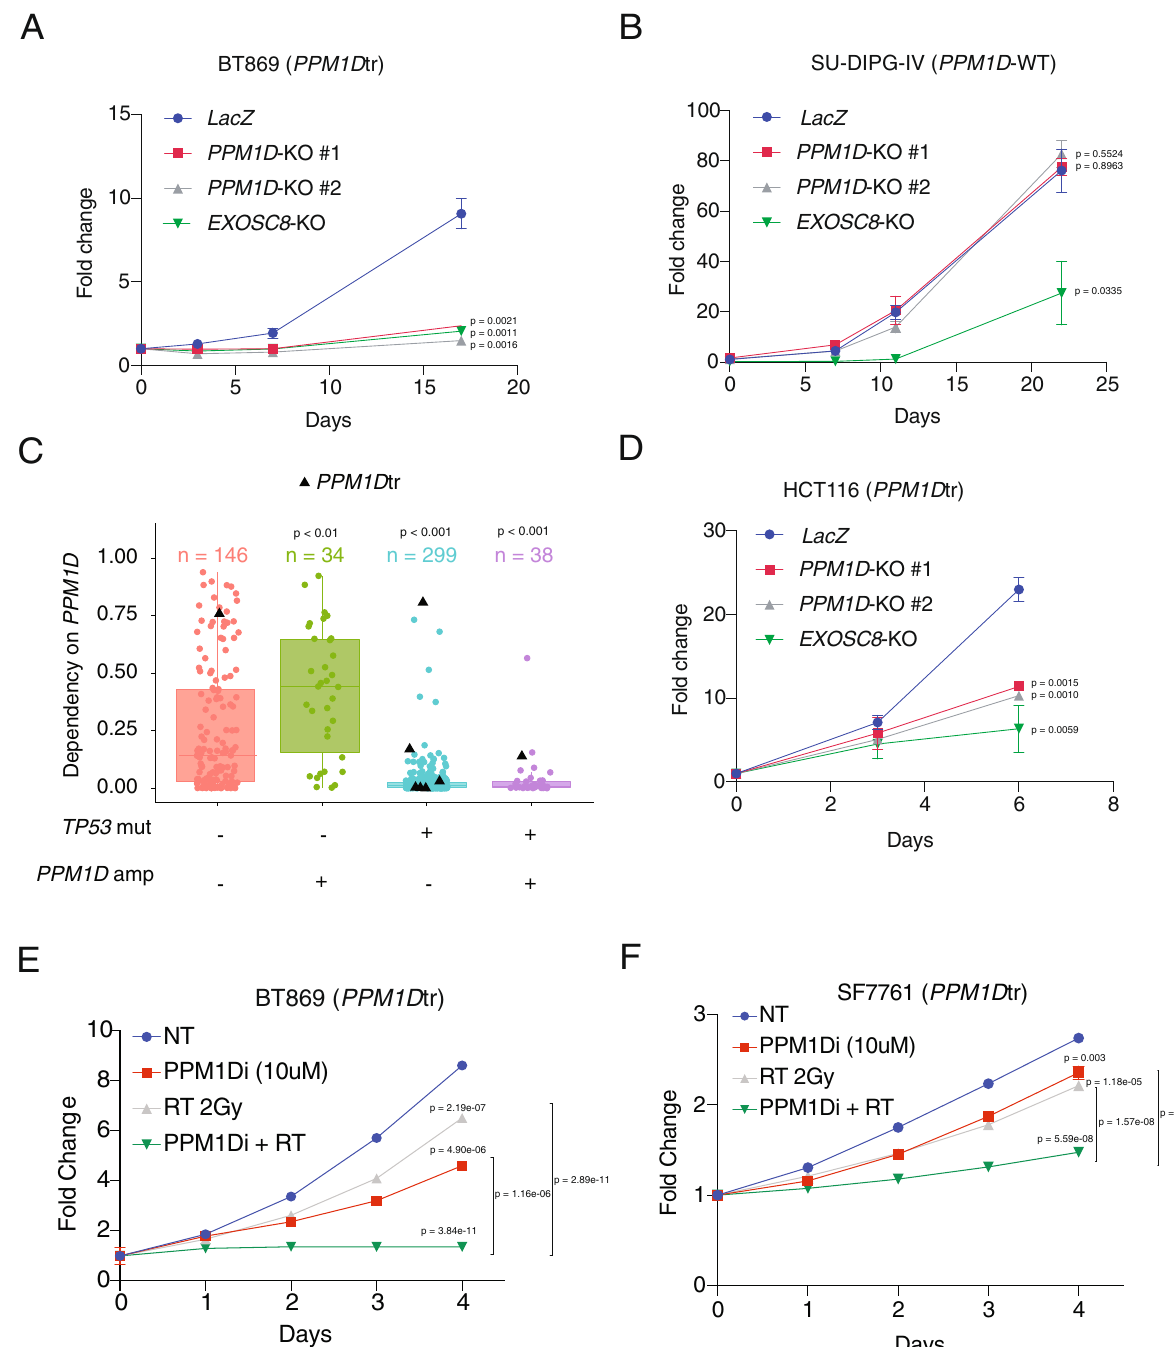
dependent on PPM1D than TP53 -mutant lines ( P < 0.0001) (Fig. 3C). Among TP53 -WT lines, PPM1D copy-number gain was associated with signi fi cantly higher probability of dependency on PPM1D ( P < 0.01) (Fig. 3C). We conclude that PPM1D is required for the proliferation of p53 wild-type cell lines, particularly those that harbor PPM1D activating genetic alterations. However, the cell lines in this dataset did not fully represent PPM1D -mutant DMGs as almost all non-DMG cell lines containing PPM1D tr mutations also harbored TP53 mutations (7/8 lines) which may be acquired during cell passaging 19 . We therefore also validated this dependency in a PPM1D tr colon cancer cell line (HCT116), which does not harbor a